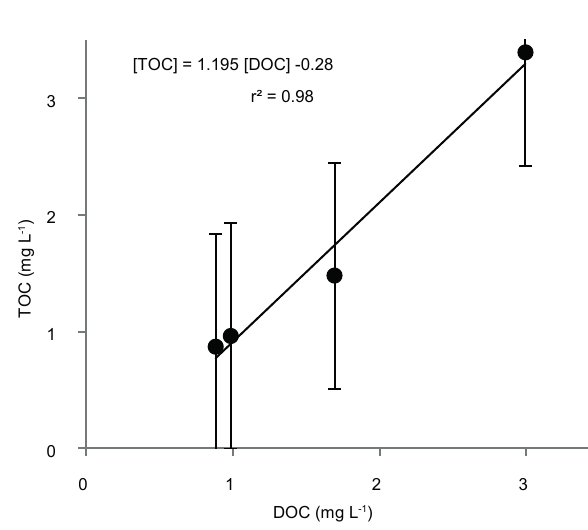
Fig. A1. Concentrations of TOC and DOC for Abiskojokken outlet, measured within a range of 3–5 days. TOC concentration was measured on a monthly basis whereas DOC was measured between 2 and 9 times per month. The measurements were conducted from April to July 2008 and the bars show minimum and maximum TOC values measured for the same months.